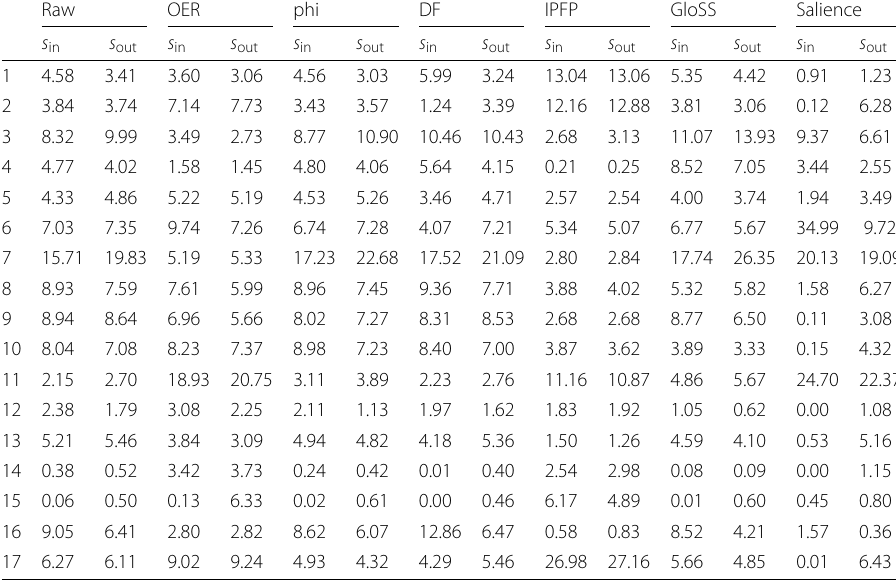
Table 19 The percentage of the total link strength of the constructed networks that flows into and out of each of the 17 disease categories in the coarse-grained network Raw OER phi DF